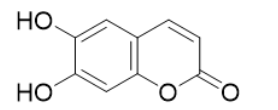
Figure 18. Chemical structure of esculetin.